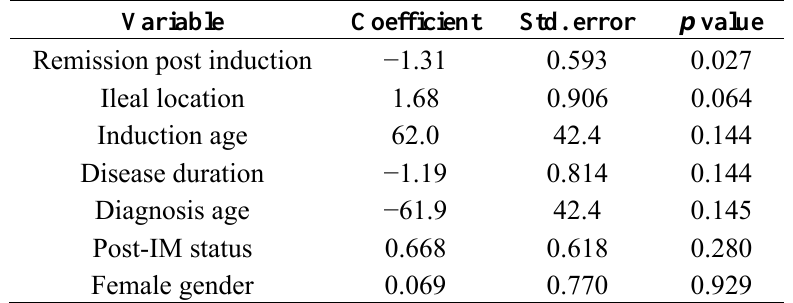
Table 2. Secondary loss of response to infliximab and clinical factors. Proportional hazards regression model.